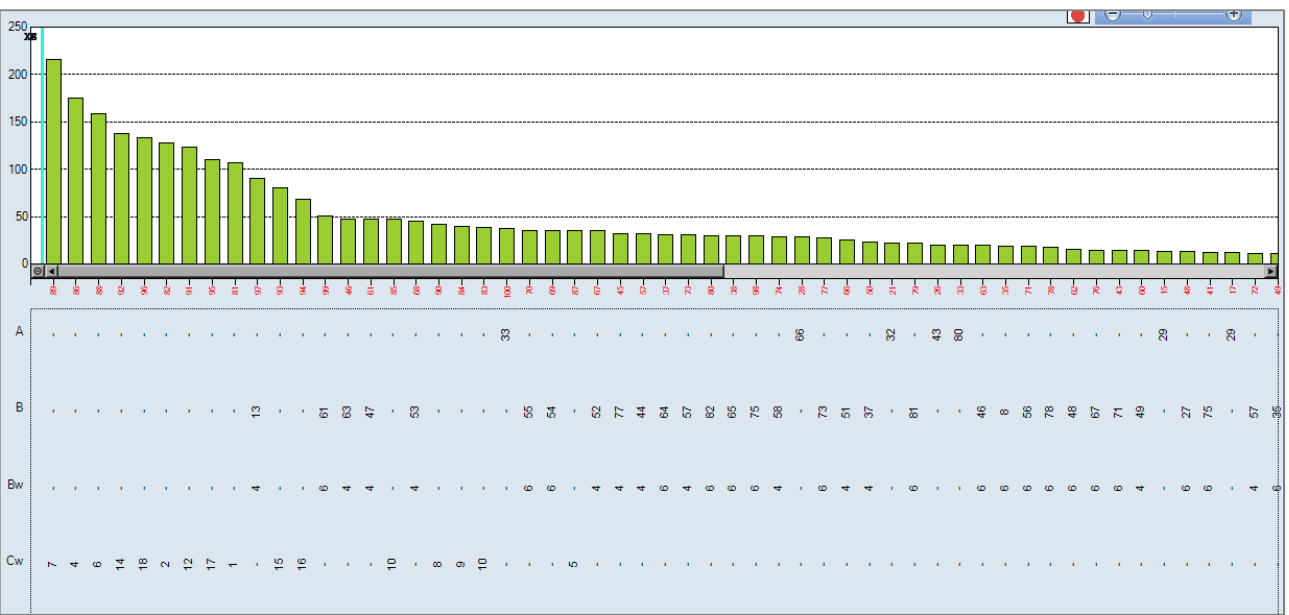
Figure 3. C1q assay: negative for all specificities. The cutoff for positivity was set at 1500